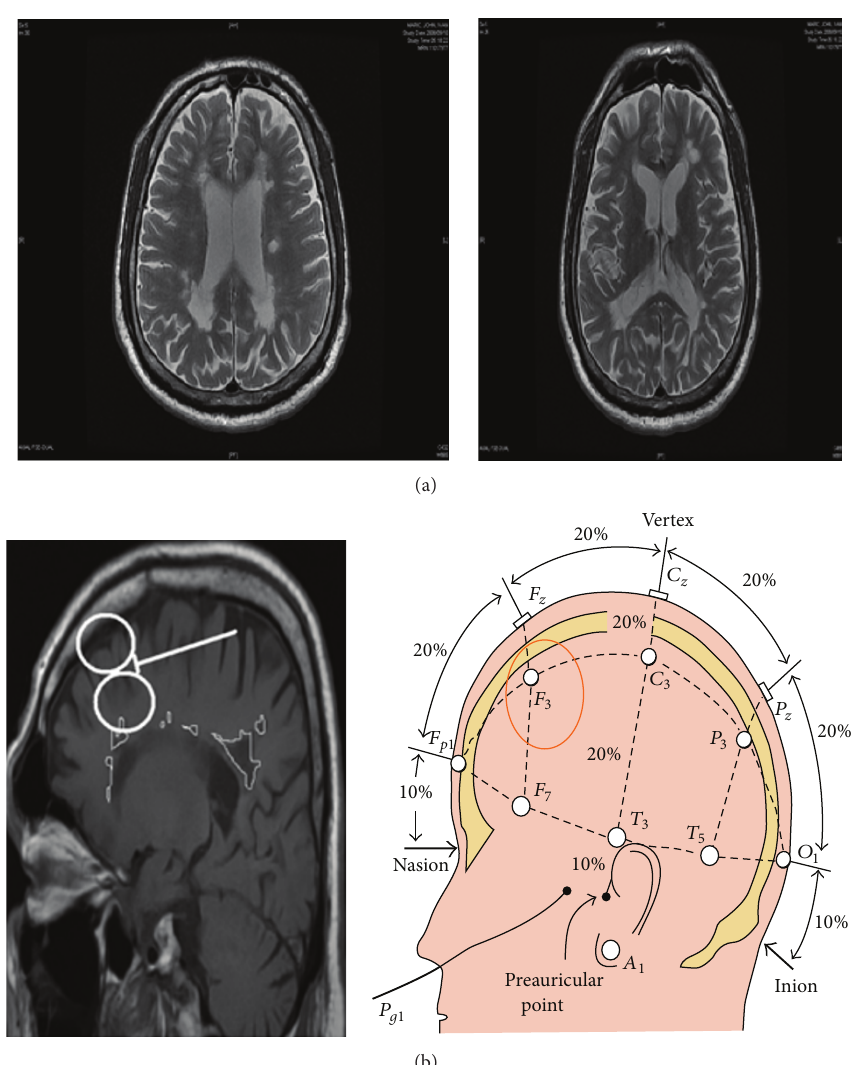
Figure 1: (a) Patient’s 𝑇 2 MRI transverse image showing several patches of white matter hyper-intensities representing demylinating lesions. (b) Patient’s 𝑇 1 MRI sagittal image (on the left) showing approximate TMS coil location using the 10-20 international EEG lead localization system (on the right). White matter lesions are marked for demonstration on the 𝑇 1 sagittal